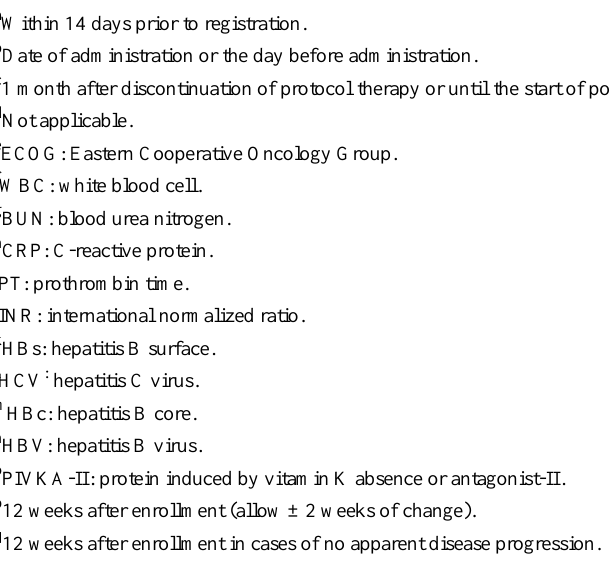
Table 1. Follow-up schedule for trial protocol. General